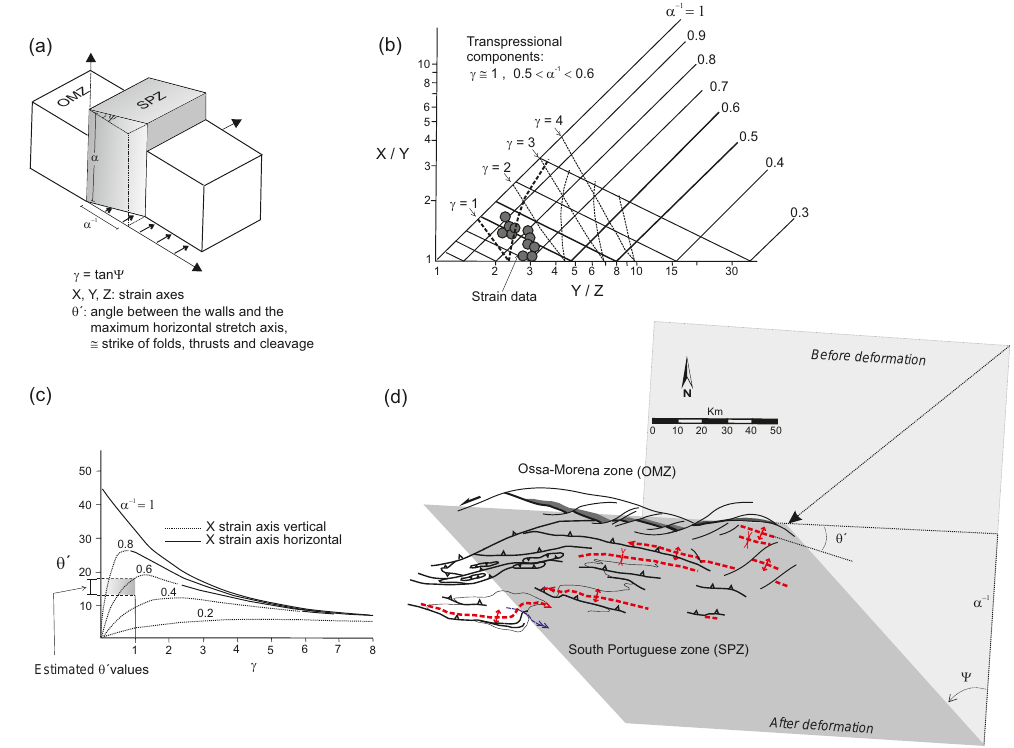
Figure 8. (a) Transpressional model of Sanderson and Marchini (1984). (b) Strain data from the SPZ suggest the values of shortening ( α) and shearing ( γ) according to this model. (c) Angle between the boundary of the transpressional block and the maximum horizontal stretch axis, according to the estimated α and γ values. (d) Sketch of the eastern SPZ showing the transpressional